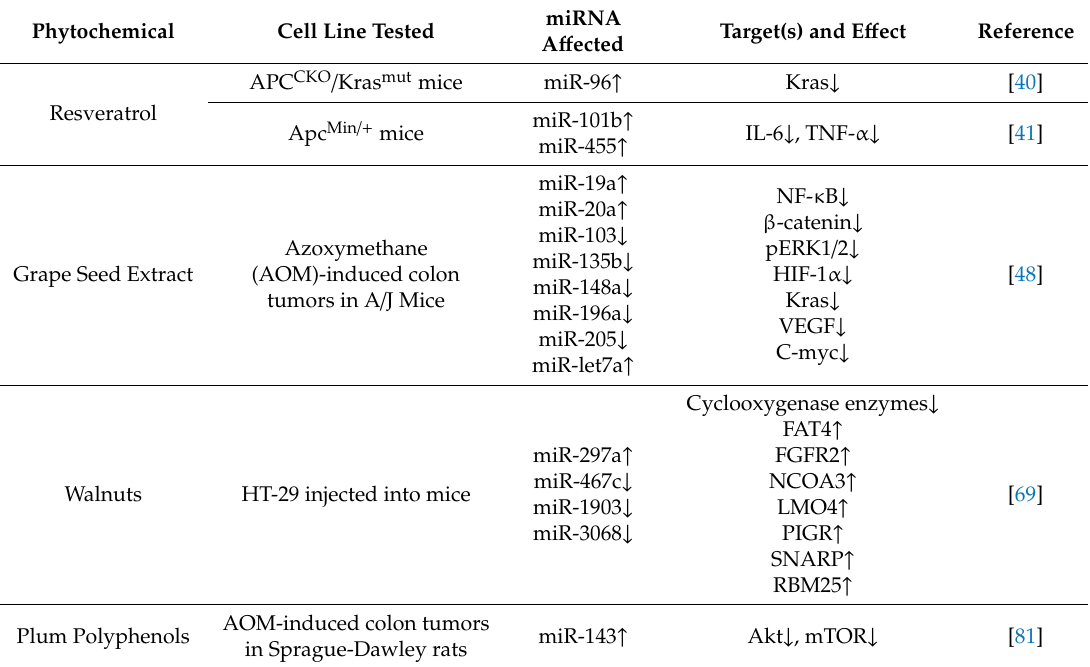
Table 2. In vivo e ff ect of phytochemicals against colorectal cancer by miRNA